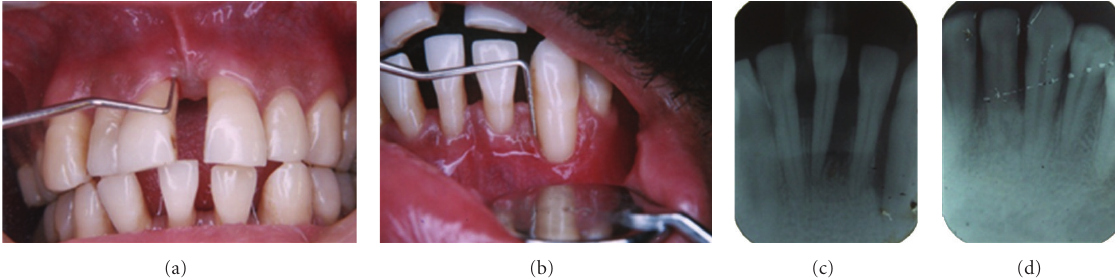
Figure 13: (a) and (b) Postoperative photographs showing probing depths within normal limits with excellent gingival condition; however, there was slight increase in recession after healing. (c) and (d) Comparison of preoperative and 1 year postoperative radiographs shows good bone fill at the defect in relation to